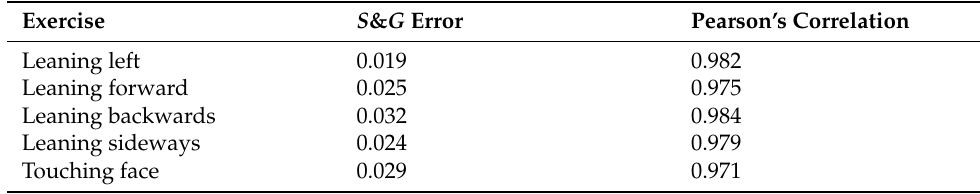
Table 4. Mean Sprague and Geers’ error and Pearson’s correlation between recorded and IK- reconstructed joint positions for all subjects.